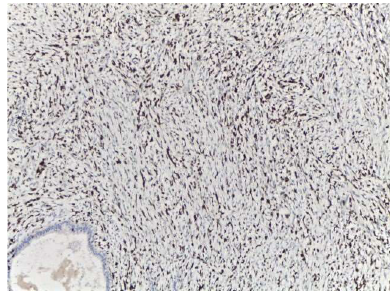
Figure 7. Ki67 immunostaining in malignant Phyllodes tumor (x100).